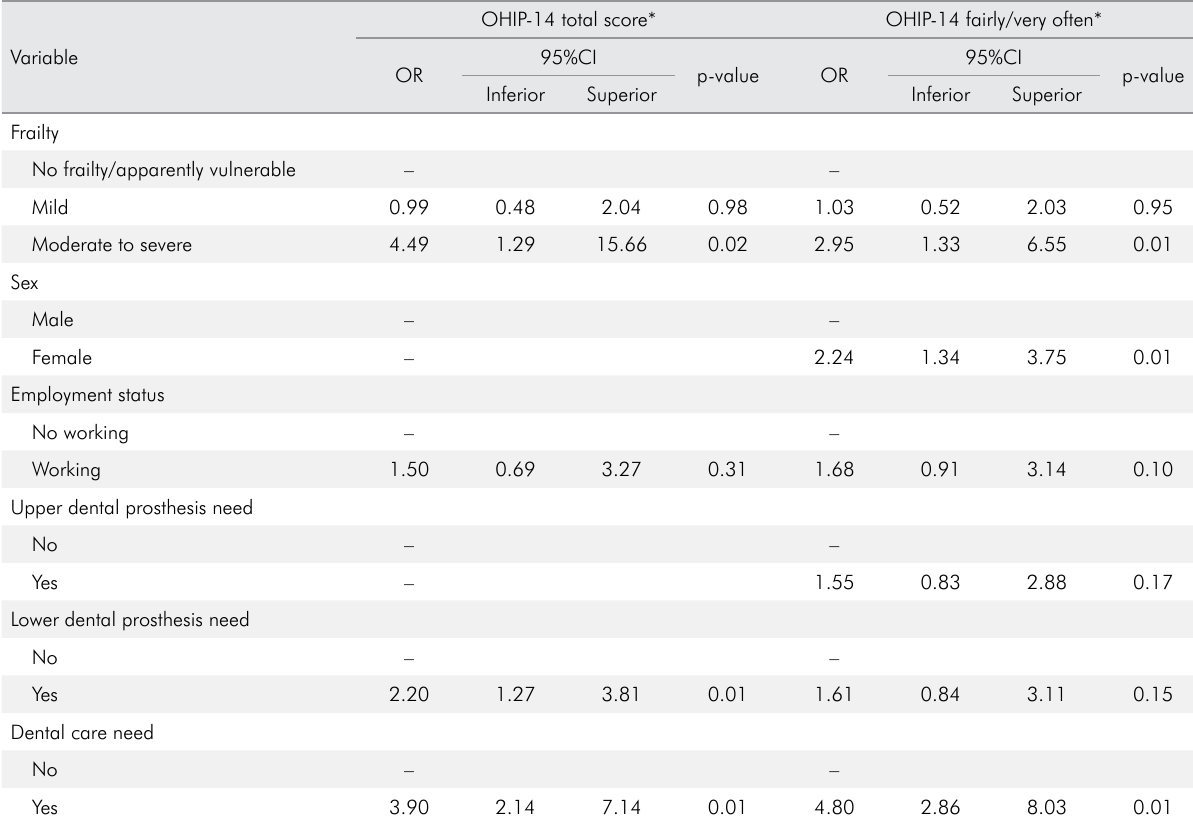
Table 4. Adjusted logistic regression analysis for the association between frailty, sociodemographic characteristics, dental clinical measures, and self-perceived dental care needs and oral health-related quality of life in community-dwelling older